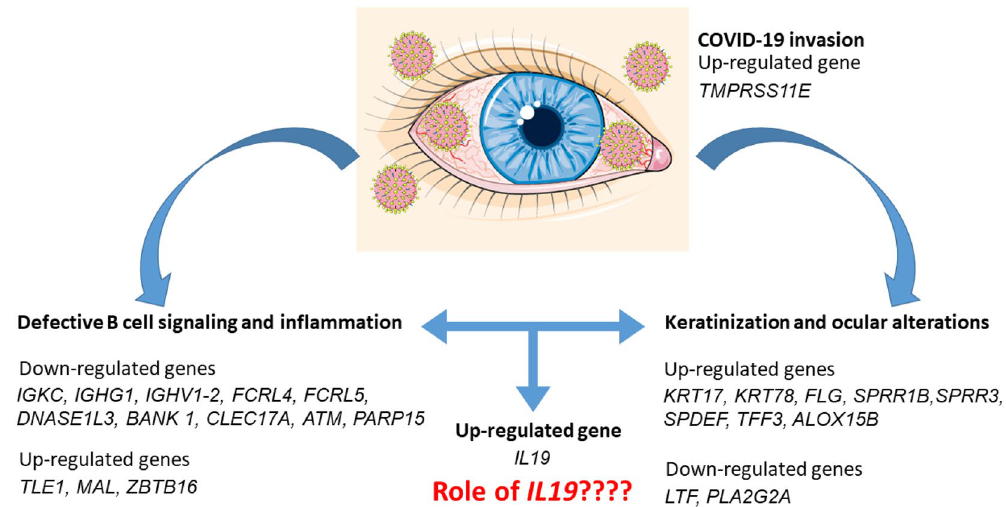
Figure 3. Schema of the down- and up-regulated genes and the processes in which they are involved. The trancriptomic analysis suggested a defective function of B cells and a process of keratinization. IL-19 may link the process, being involved also in keratinocyte proliferation. The figure was made taking the images from Servier Medical Art ( available at http:// smart. servi er. com/), licensed under a Creative Commons Attribution 3.0 Unported License